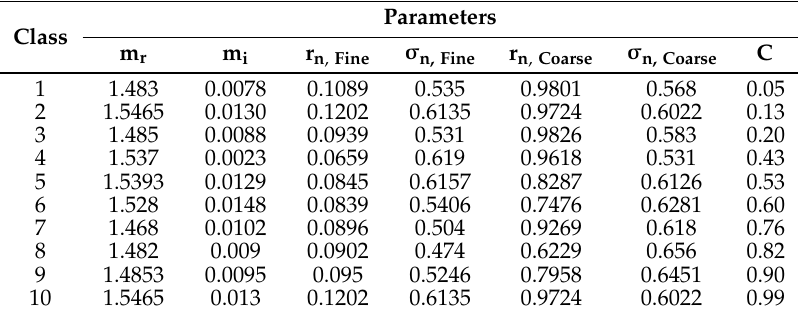
Table 3. The parameters of aerosol models for intensity measurement [26,27]. m r is the real part of the complex refractive index, m i is the imaginary part of the complex refractive index, and C is the percentage density of fine particles by number. The different classes show different aerosol scattering properties. The ρ 0 p µ s , µ v , ϕ q , T p µ s q , T p µ v q , and S values that correspond to these classes, which guarantee